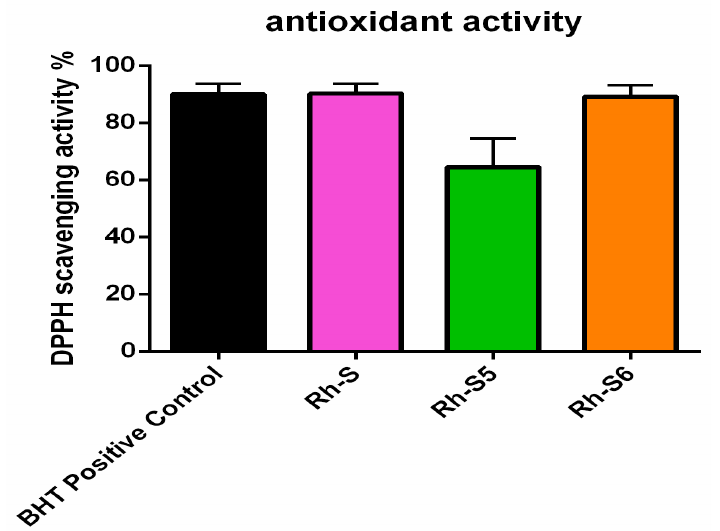
Figure 10. Antioxidant activity of the investigated compounds: Rh-S, Rh-S5, and Rh-S6.